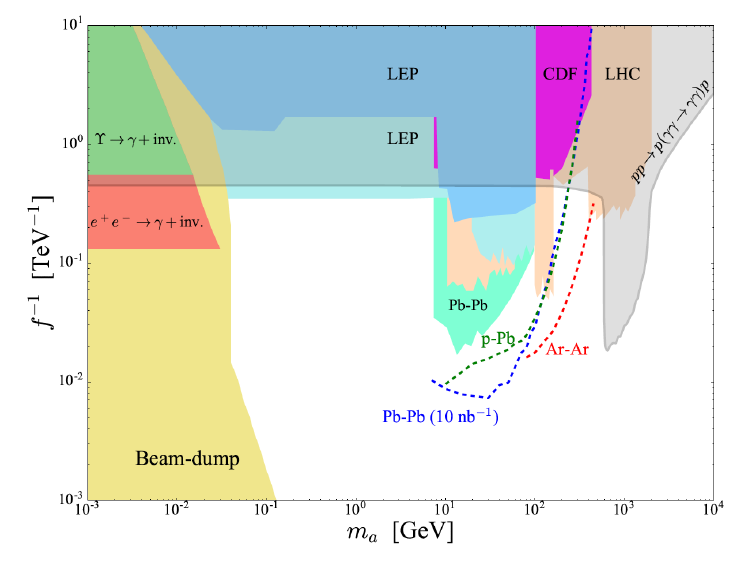
Figure 6: Coupling vs ALP mass sensitivity plot. The reach using the measurement of two intact protons and the two photons for photon-induced processes is shown as a grey